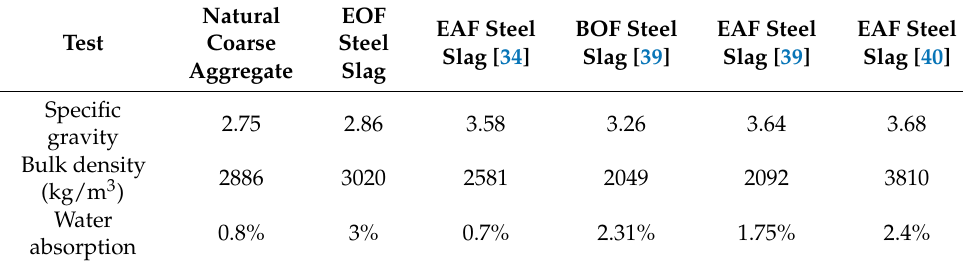
Table 3. Physical properties of coarse aggregate.